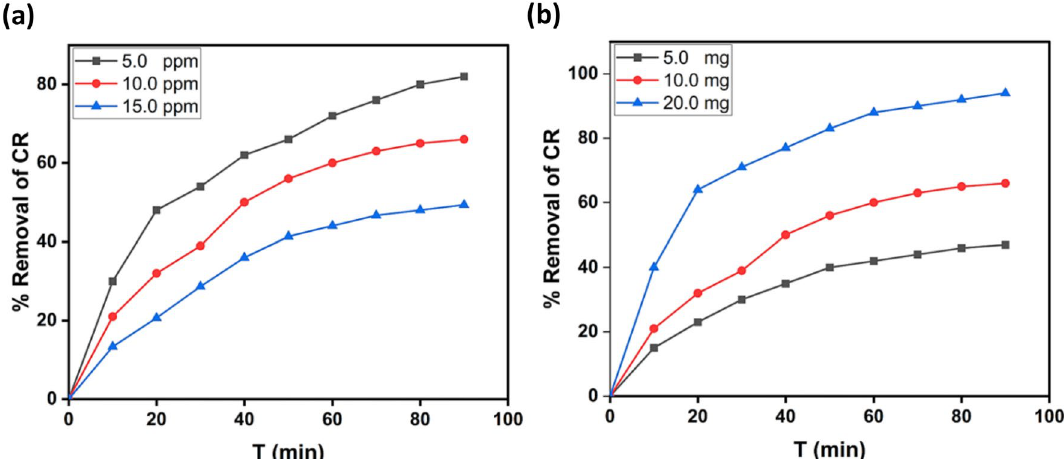
Figure 6. ( a ) Differences of removal percentage with contact time as a function at various initial CR concentrations (5, 10, and 15 mg/l) at pH 7 and 10.0 mg rGO-P nanocomposite. ( b ) Effect of the photocatalyst amount (in mg) on the removal efficiency of CR (50 ml CR solution, 10 mg/l at T = 25 °C and pH 7).